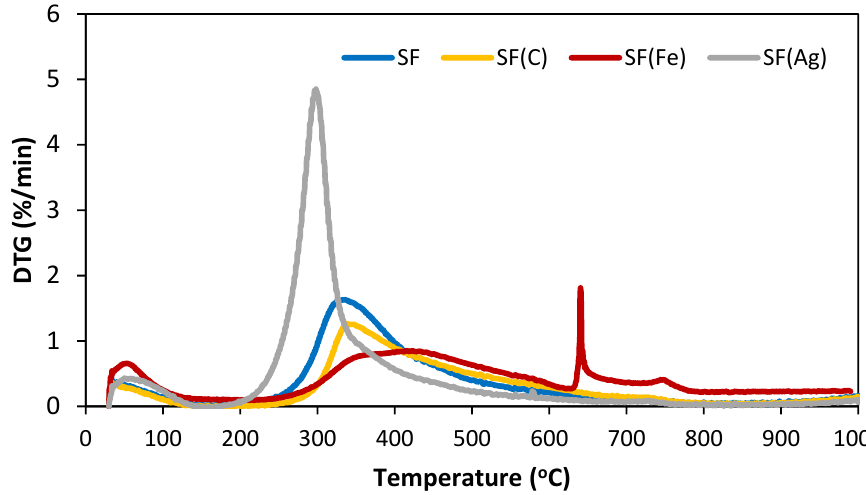
Figure 4. DTG curves of SF green foams in N 2 atmosphere from ambient up to 1000 °C.